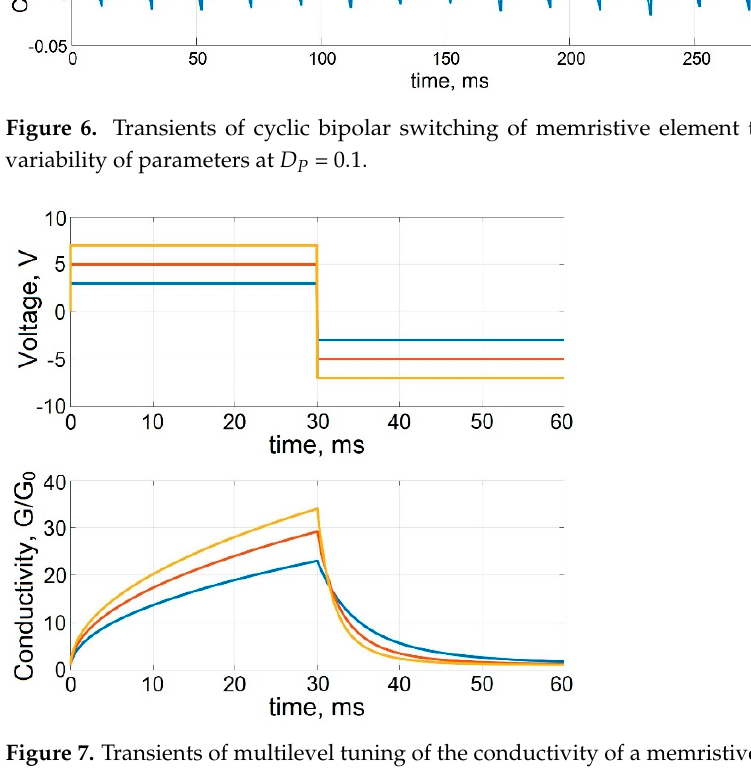
Figure 7. Transients of multilevel tuning of the conductivity of a memristive element. Table 2. Model parameters for a memristor with the structure shown in Figure